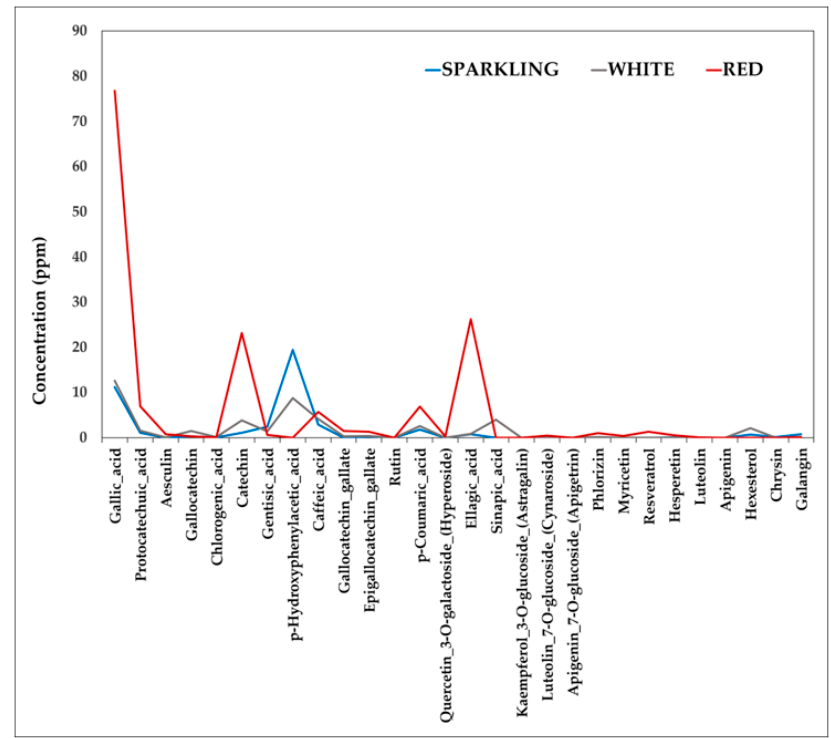
Figure 5. The trends of all the non-anthocyanins determined in the analysed Italian wines distin- guishing among sparkling, white and red wines.